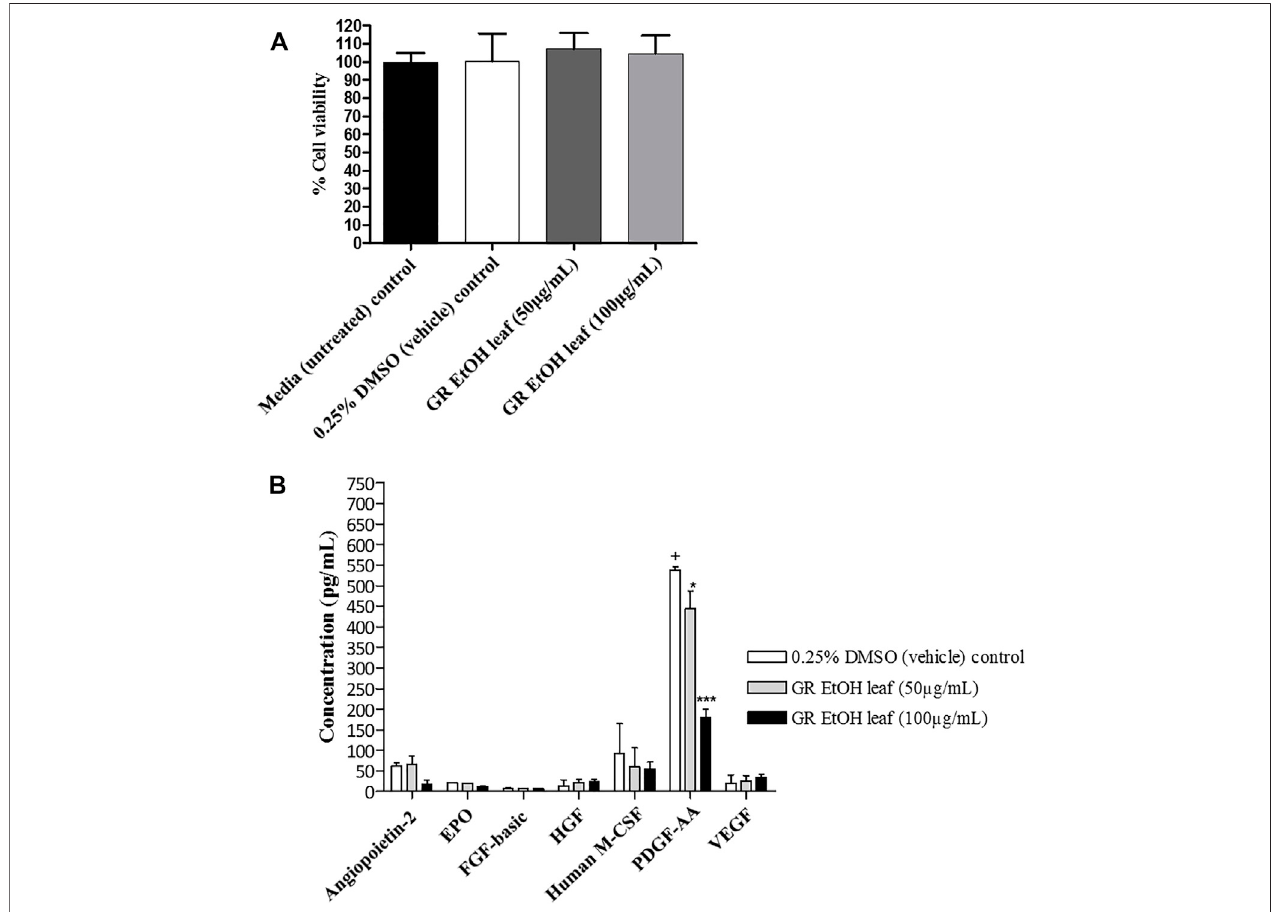
FIGURE6|(A) Cellviability(%)ofhumankeratinocytes(HaCat)treated with G.radlkoferi EtOH leafextract (at50and 100 μ g/ml)after 18 h. Controlsincluded cells grown in media (untreated) and cells treated with 0.25% DMSO (vehicle) control. Data shown are mean ± SD ( n = 2). No statistical signi fi cance was observed when comparedtountreatedcells.Statisticalanalysiswasdoneusingone-wayANOVAfollowedbyDunnett ’ smultiplecomparisontest (B) Theeffectof G.radlkoferi EtOHleaf extract (at50and 100 μ g/ml) on theproduction ofhumangrowth factors (pg/ml) inHaCat cells after 18 h incubation. Datashown are mean± SD( n =3). Statistical analysis was done using one-way ANOVA followed by Bonferroni ’ s posttest, where * p < 0.05 and *** p < 0.001 indicated statistical signi fi cance when compared to the 0.25% DMSO (vehicle) control (+).